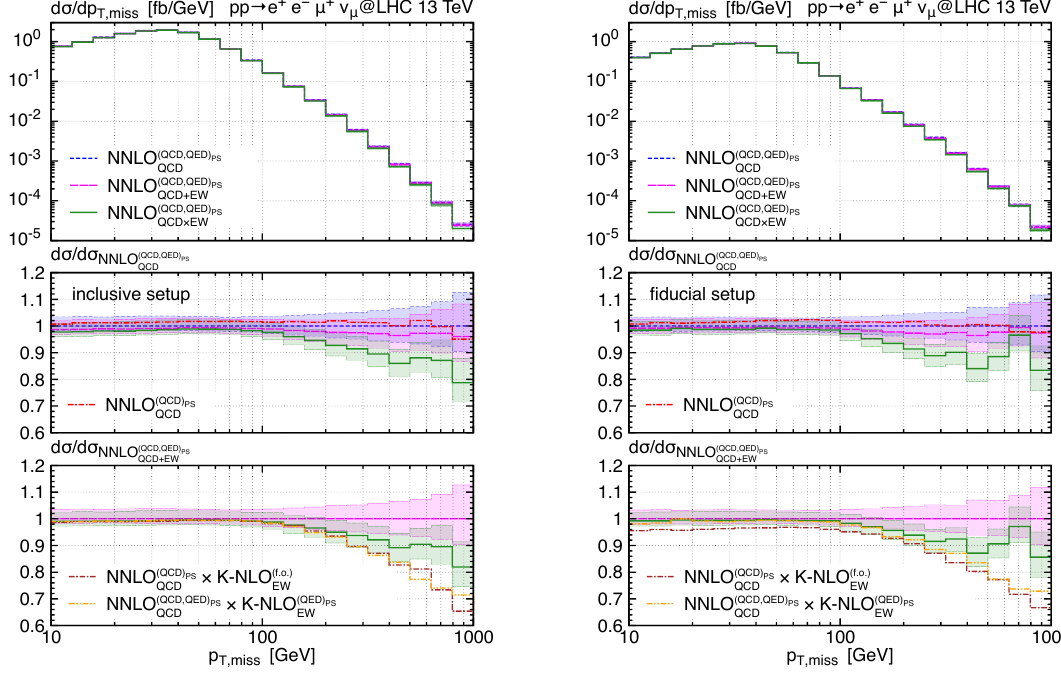
Figure 5. Differential distributions in the missing transverse-momentum p tion in the inclusive setup (left) and fiducial setup (right). See text for